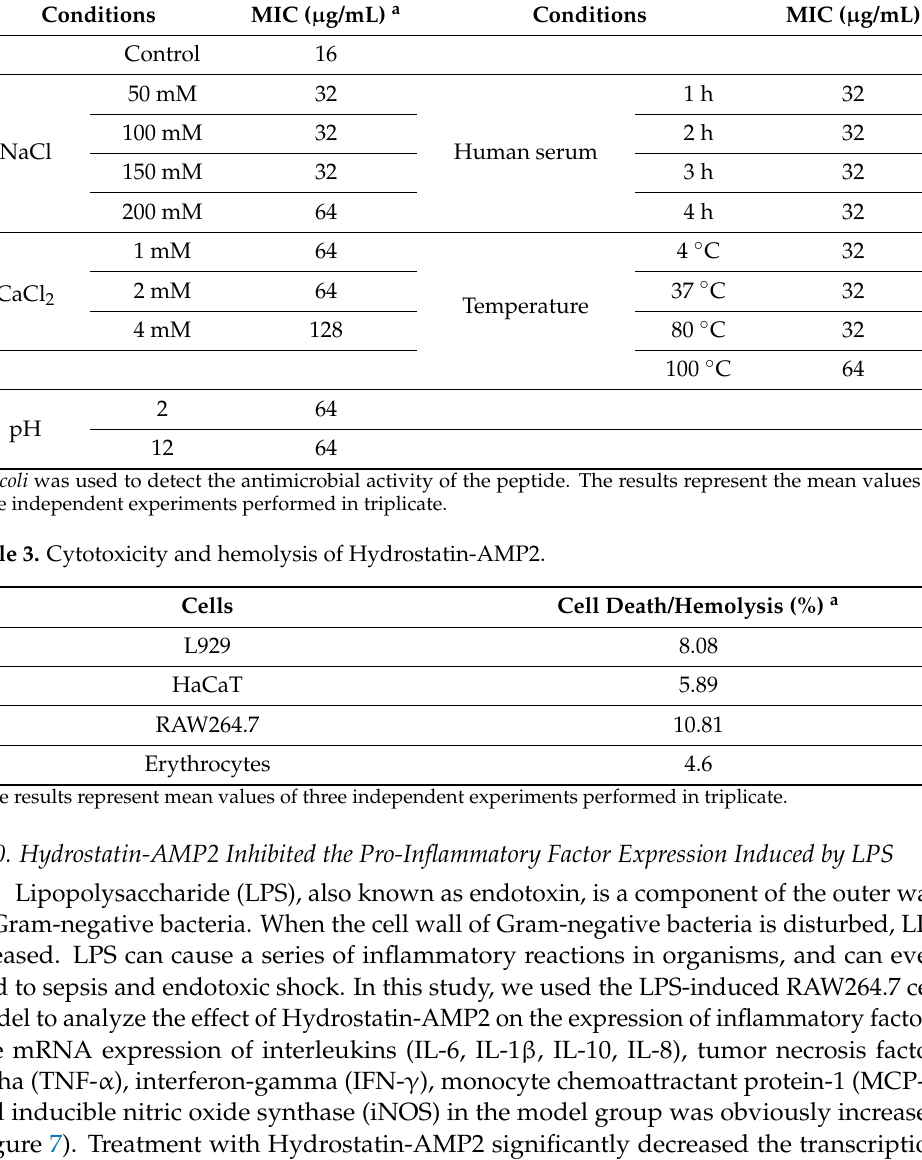
Table 2. Effects of salts, pH, serum, and temperature on the antimicrobial activity of Hydrostatin-AMP2. Conditions